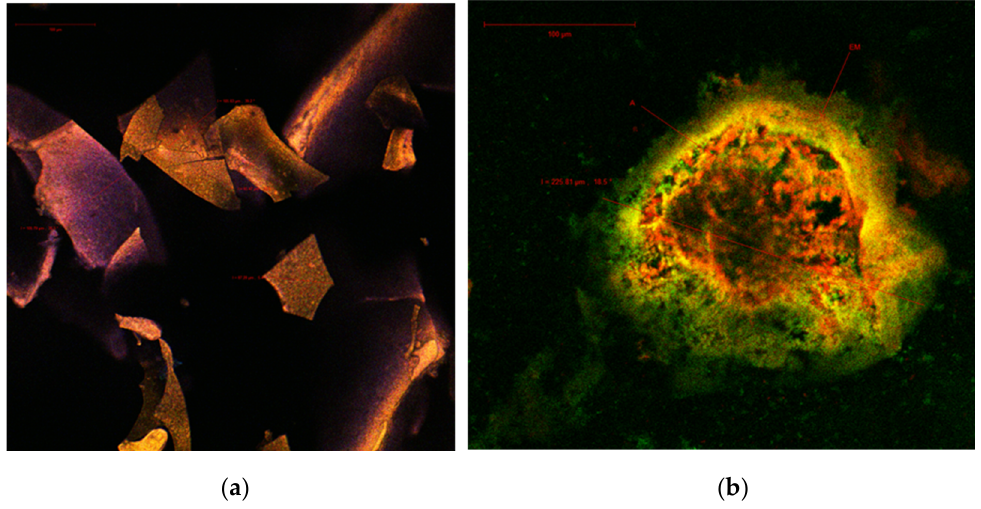
Figure 2. Confocal laser scanning microscopy images of ( a ) the native microencapsulated cornelian cherries powder and of ( b ) the fluorophore dyed microencapsulated cornelian cherries powder.